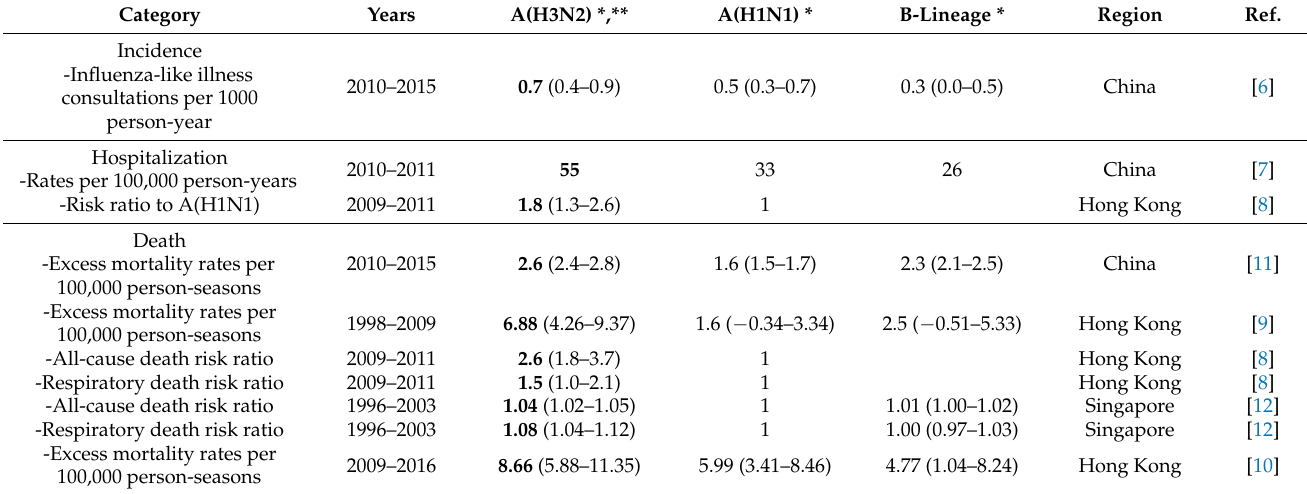
Figure 2. Number of influenza-positive specimens by type and subtype reported in six countries of the Western Pacific region in which A(H3N2) was the dominant strain from 2010 week 21 to 2020 week 20. Specimens were collected in China ( A ), Japan ( B ), the Republic of Korea ( C ), Australia ( D ), Singapore ( E ) and Mongolia ( F ). Data Source: FluNet (www.who.int/flunet, accessed on 11 November 2021). Table 2. Severity of outcomes associated with influenza cases by virus type, region and